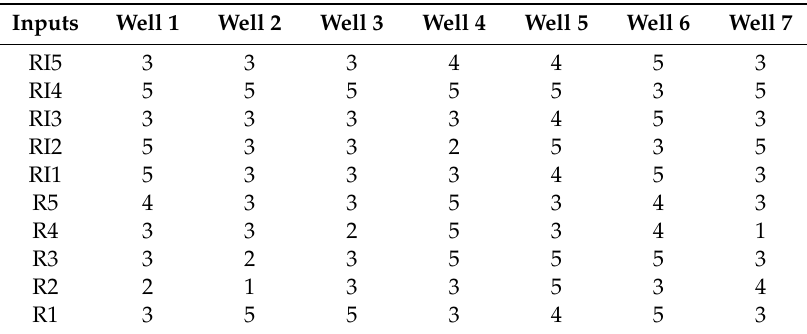
Table 6. Ranked sensitivity analysis index of each